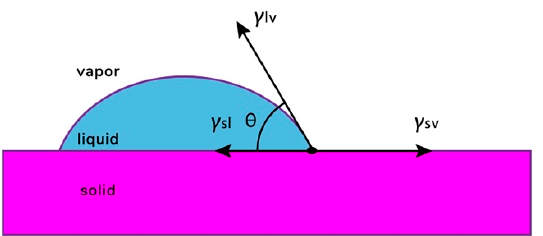
Figure 16. Schematic of a sessile ‐ drop contact angle system [526]. Reproduced with permission from Kwok, D.Y. and Neumann, A.W., Advances in Colloid and Interface Science; Elsevier Science B.V.,